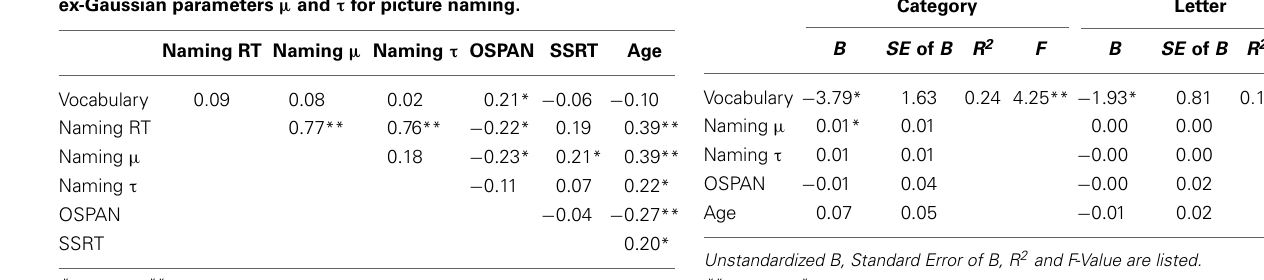
Table 2 | Relationships between operation span score (OSPAN), stop-signal response time (SSRT), age, and naming RT and ex-Gaussian parameters µ and τ for picture naming.